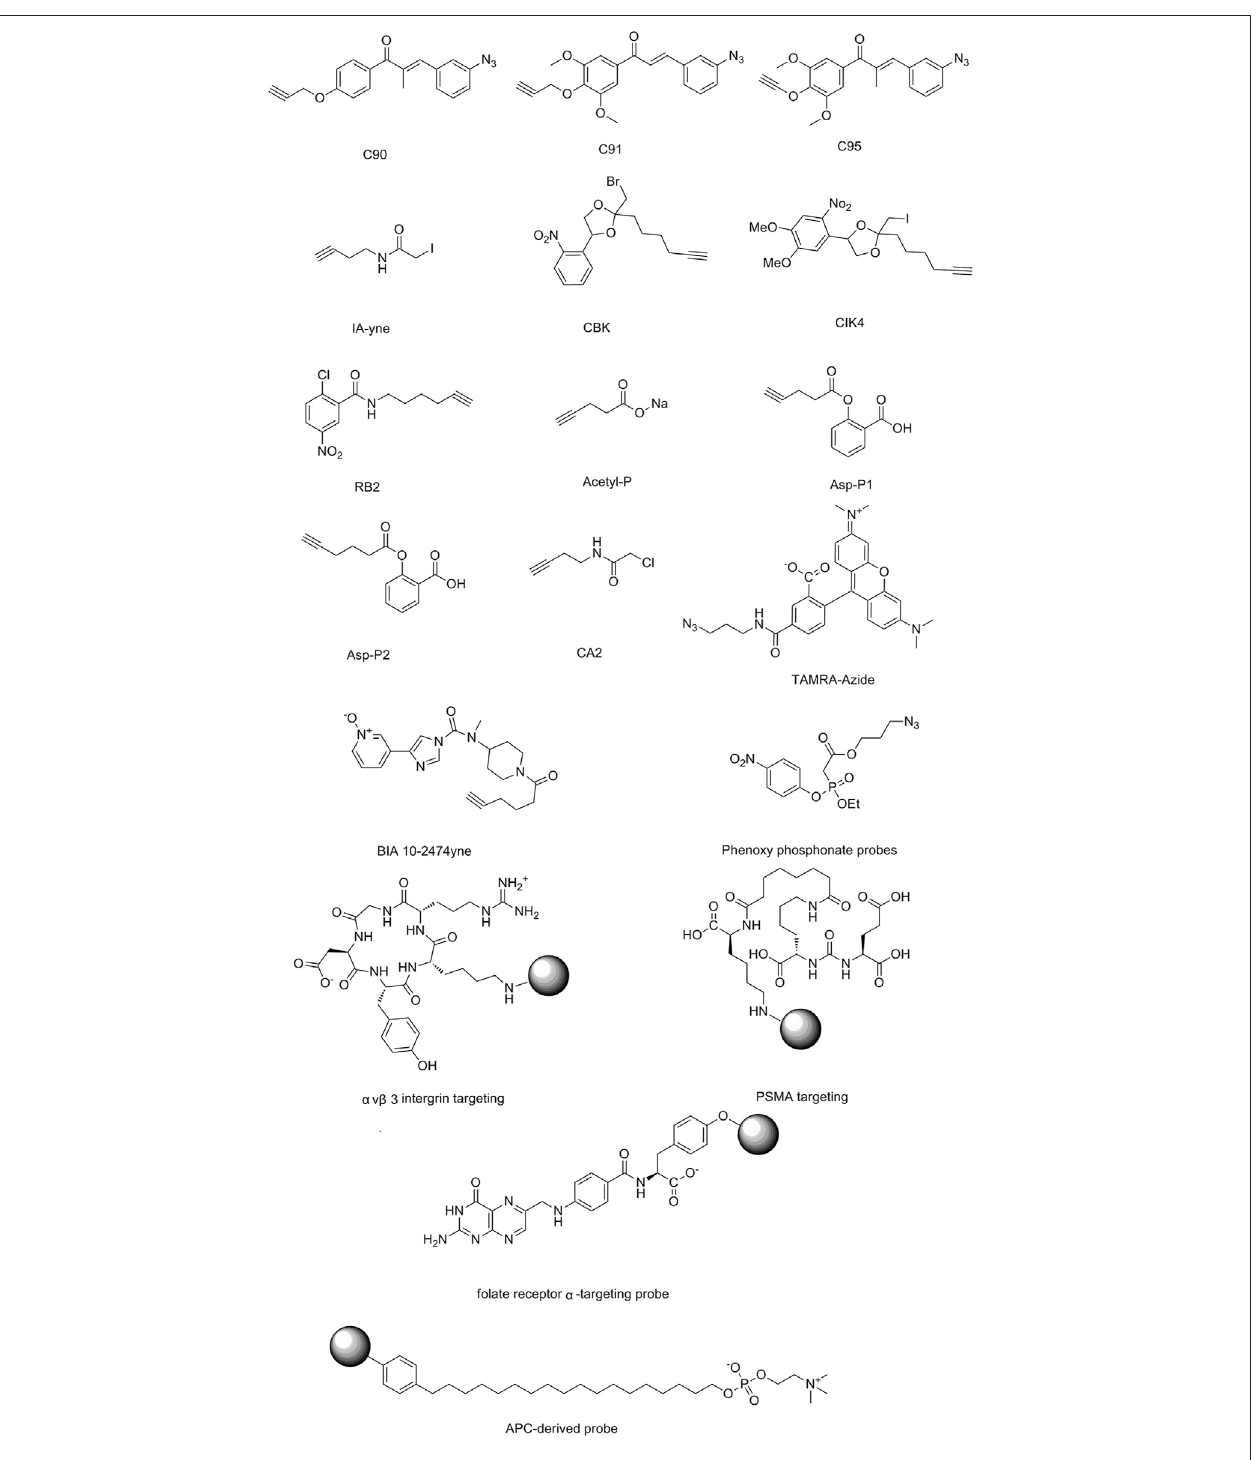
FIGURE 6 | Structures of ABPP and CCCP probes for bioactive natural products.